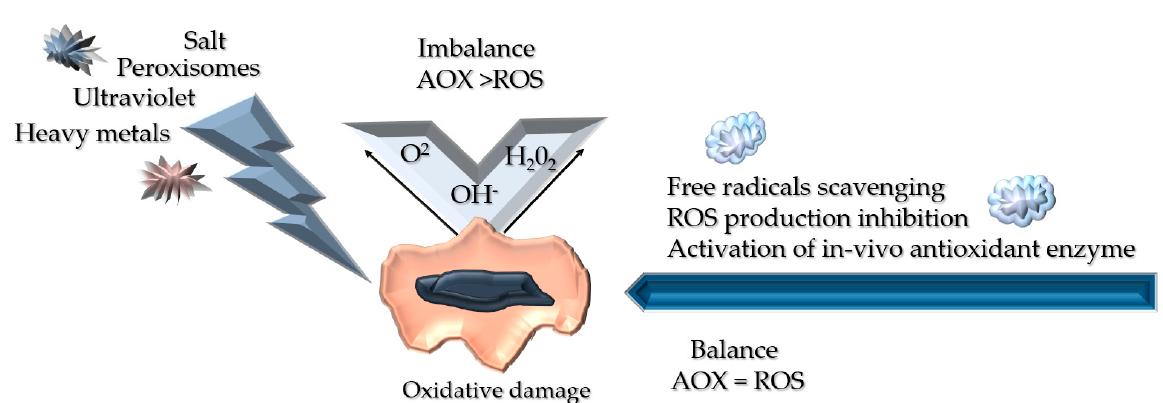
Figure 3. Illustrates the reactive oxygen species (ROS) generation, impact, and its eradication therapy. Oxidative stress can be triggered by external stimuli such as UV and salt, which will interfere with the wound’s homeostasis, leading to vital damage towards the cell’s continuous development. However, in a balanced state, these reactive oxygen species can be inhibited by antioxidants via free radical scavenging hence aiding in antioxidant enzyme system activation, which endorses non-enzymatic antioxidants (AOX) [19].